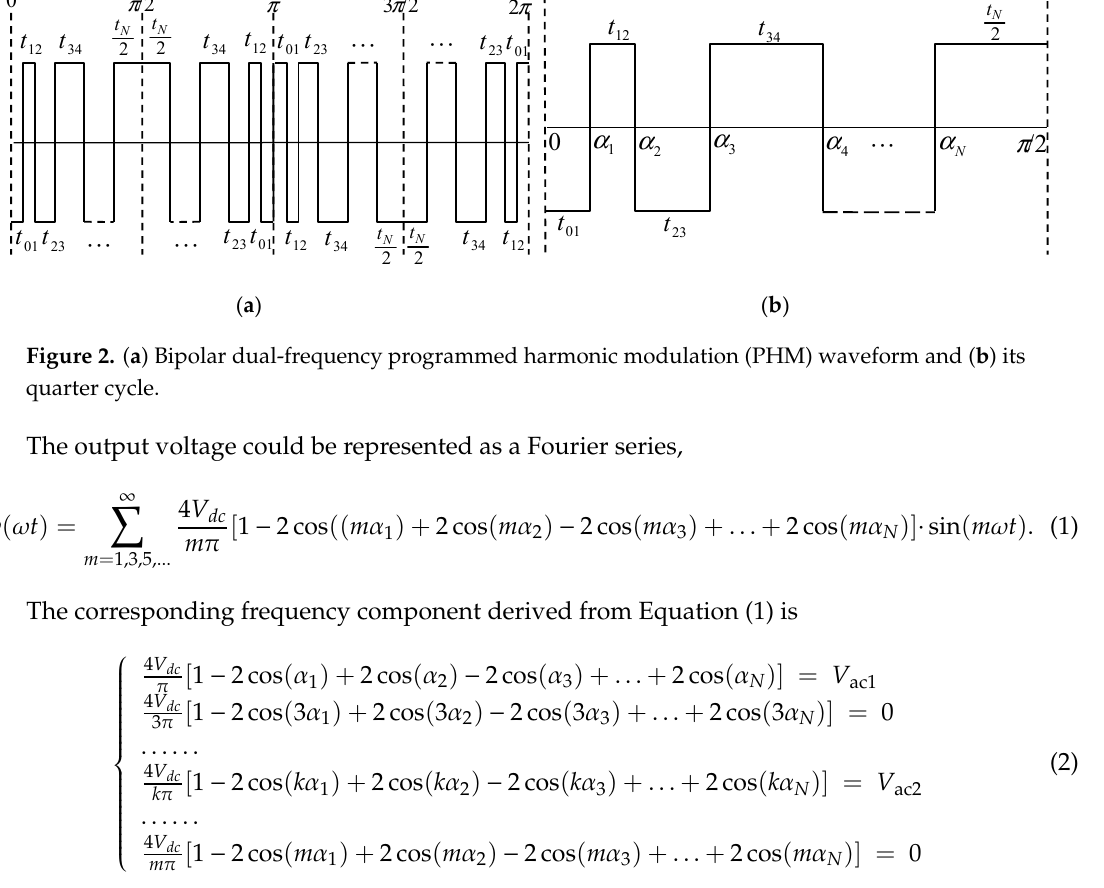
Figure 1. Topology of GaN-based single phase full bridge inverter.